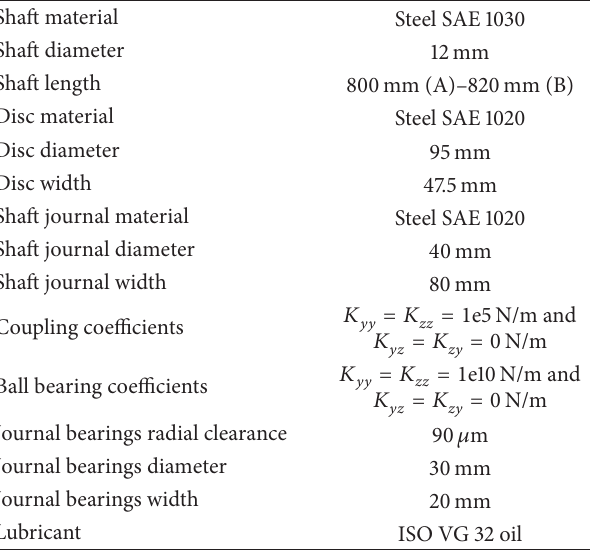
Table 1: Details concerning both test rig configurations.